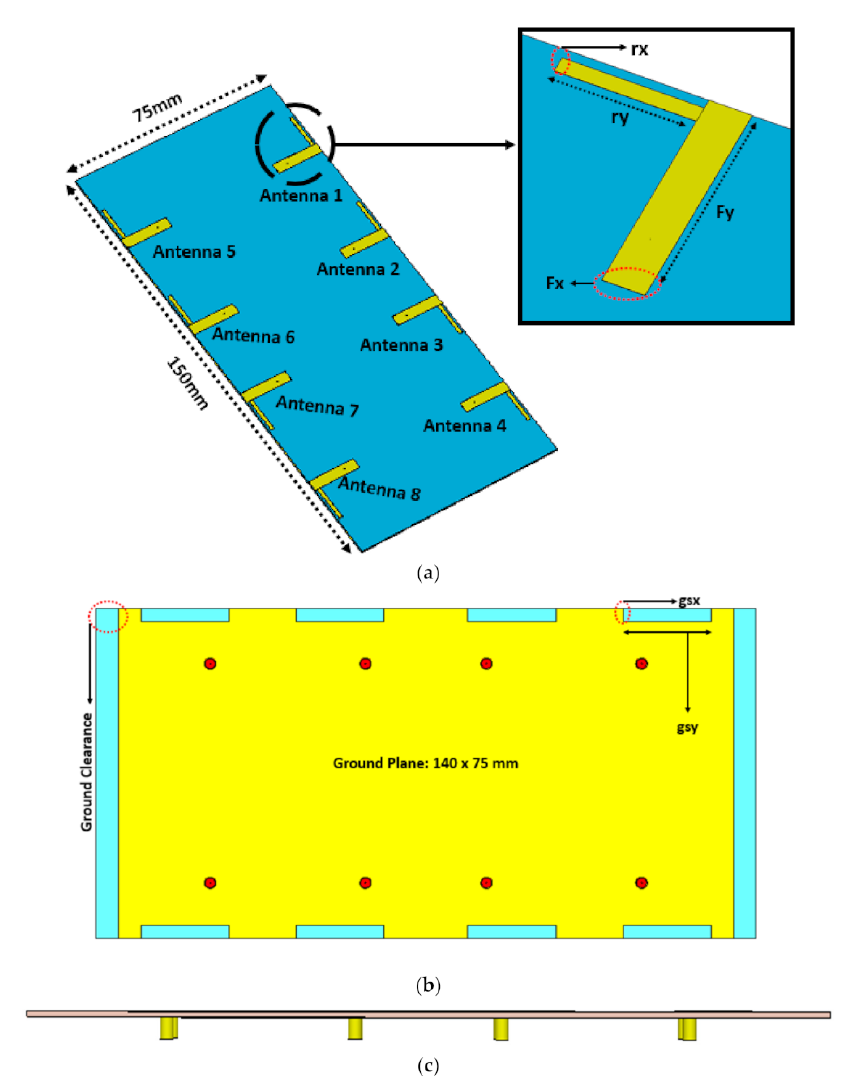
Figure 1. Proposed Dual Band Antenna View. ( a ) Overall Front View with close view of single element ( b ) Back View ( c ) Bottom View showing coaxial